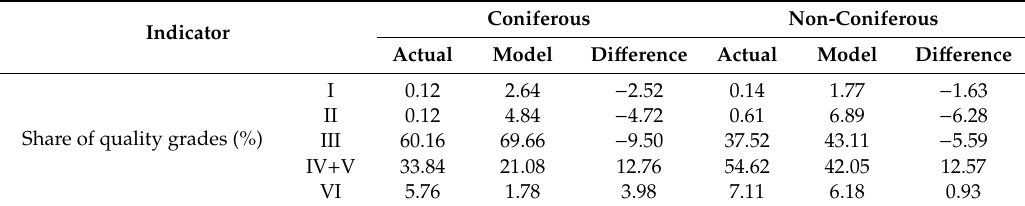
Table 5. Comparison of the actual and model shares of quality